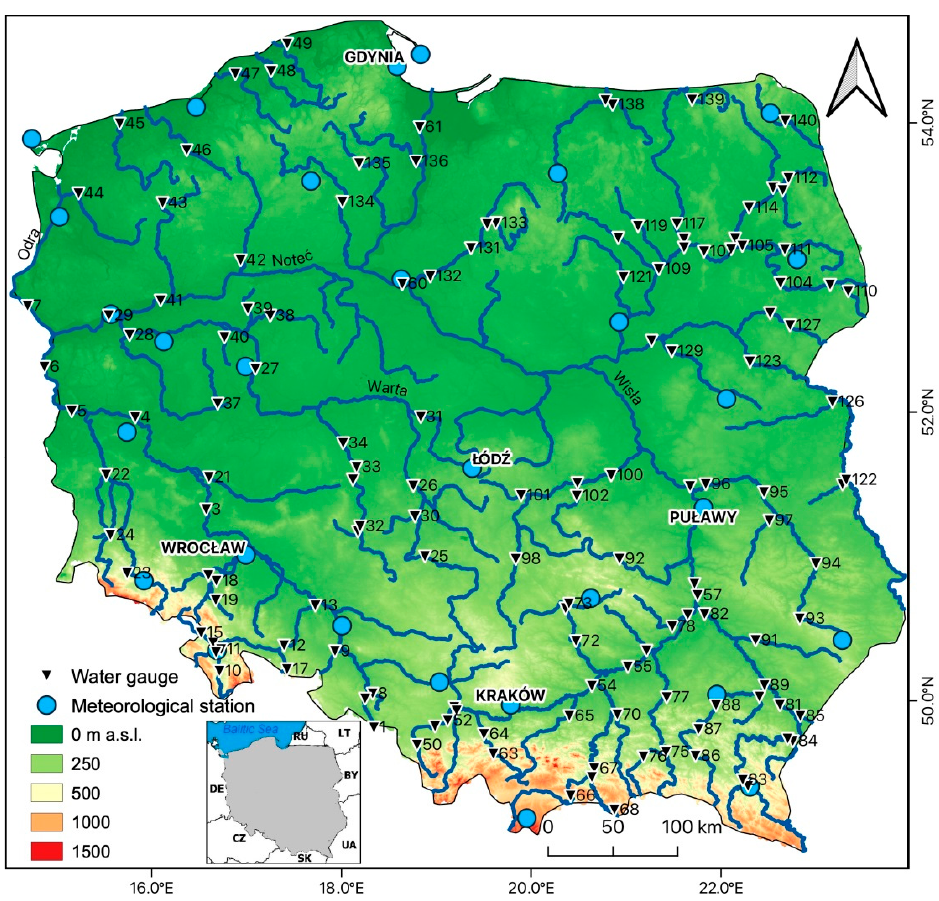
Figure 1. Position of the analyzed water gauges and meteorological stations in Poland.